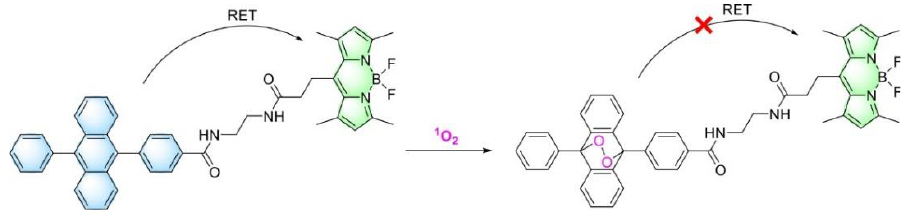
Scheme 2. Reaction of BODIPY-DPA 11 with singlet oxygen.